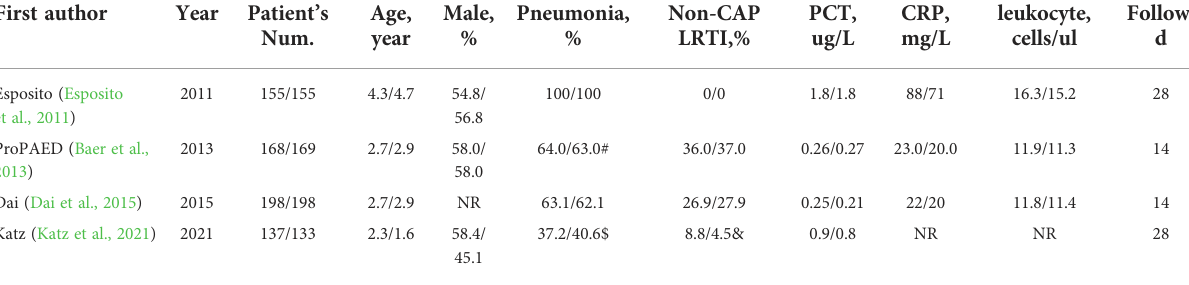
TABLE 2 Baseline characteristics of patients in the PCT-guided and empirical antibiotic therapy groups.